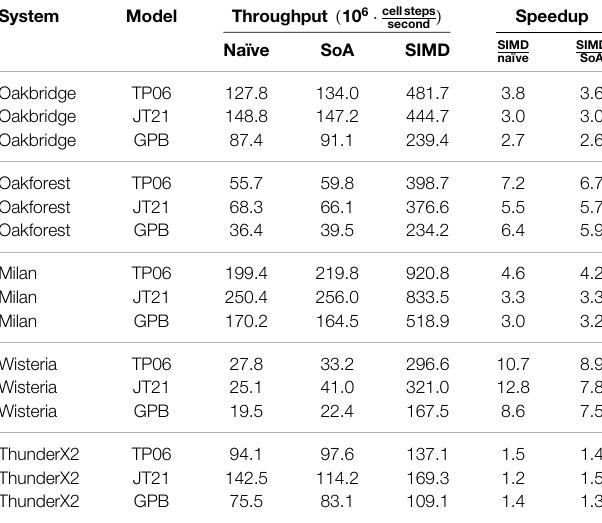
TABLE 7 | Multi-threaded performance of naïve and auto-vectorised implementations;TheFEschemeisused; C =11688851cells. “ SoA ” refersto the “ struct of arrays ” memory layout discussed in Section 2.3.2 .